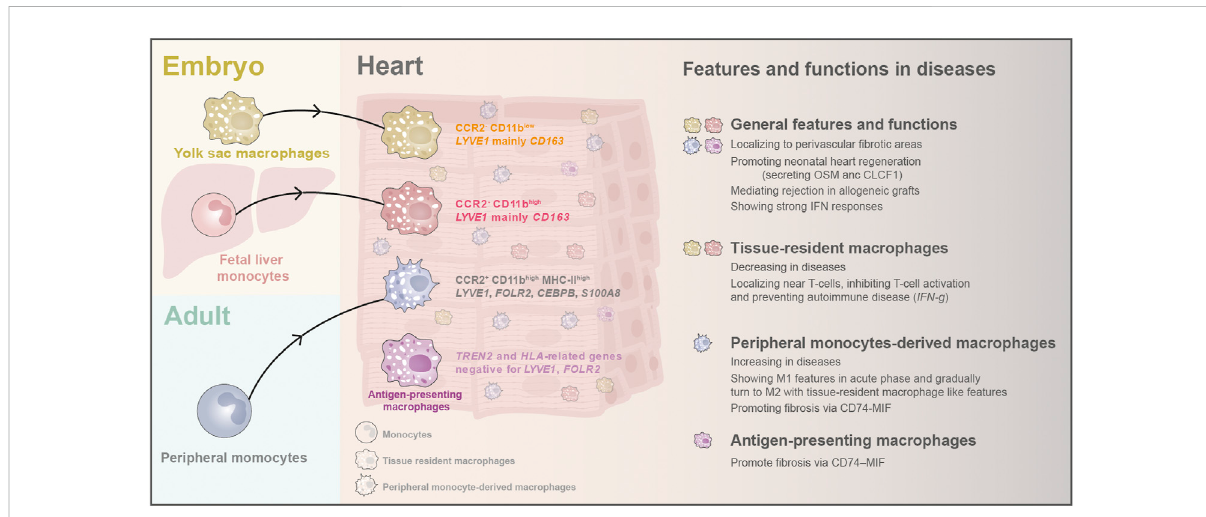
FIGURE 5 The origins and classi fi cation of macrophages and their newly discovered features and biological functions in heart diseases. In early embryos, yolk sac macrophages and fetal liver monocytes arrive the hearts and stay as tissue-resident macrophages. After birth, monocytes from peripheral blood emigrate into the heart and become another critical part of cardiac macrophages. Recently, scRNA-seq found a novel antigen-presenting macrophagepopulationinadult human hearts. Cardiac macrophages have been found to localizeto perivascular fi brotic areasafter injury,and they can promote CM regeneration in neonatal hearts. They are also activated in the graft rejection process and can induce strong IFN responses. Macrophages display different features and functions in heart diseases depending on their